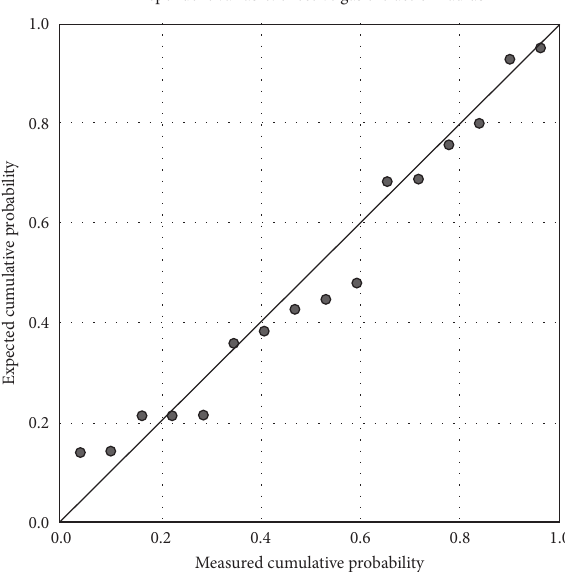
Figure 9: Scatter plot of regression standardized